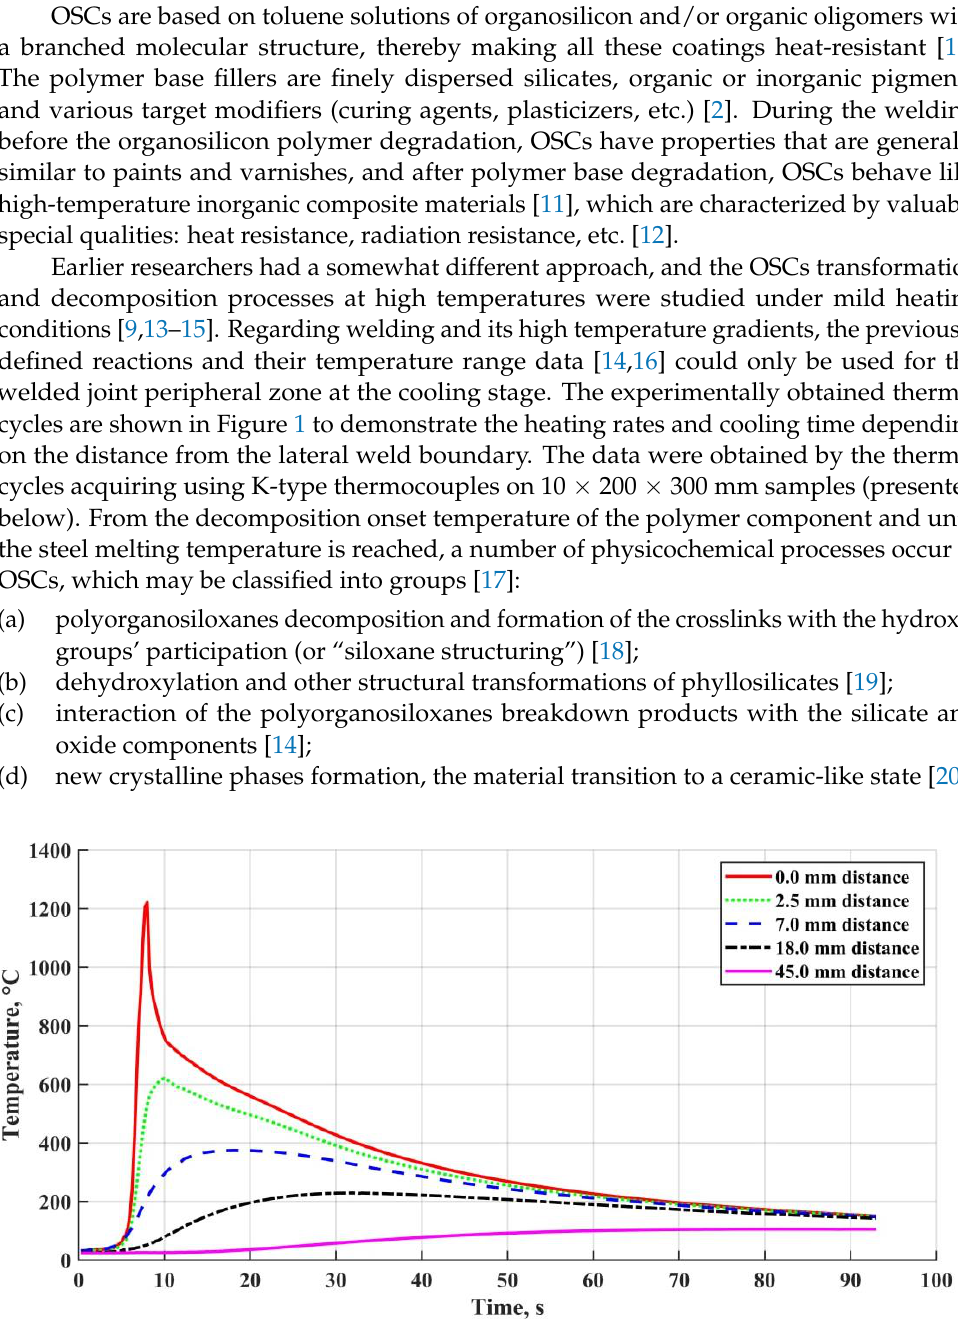
Figure 1. Welding thermal cycles at different distances from the weld boundary.